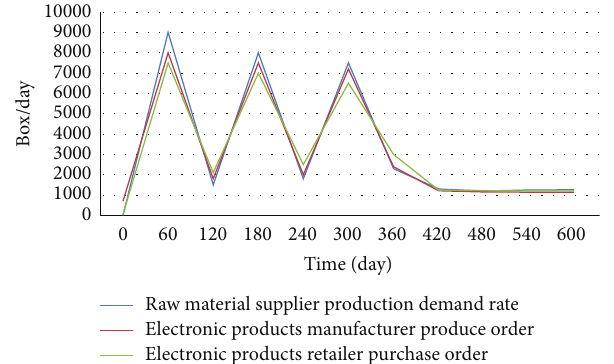
Figure 5: The environmental policy index = 2, the order demand fluctuations in various members.